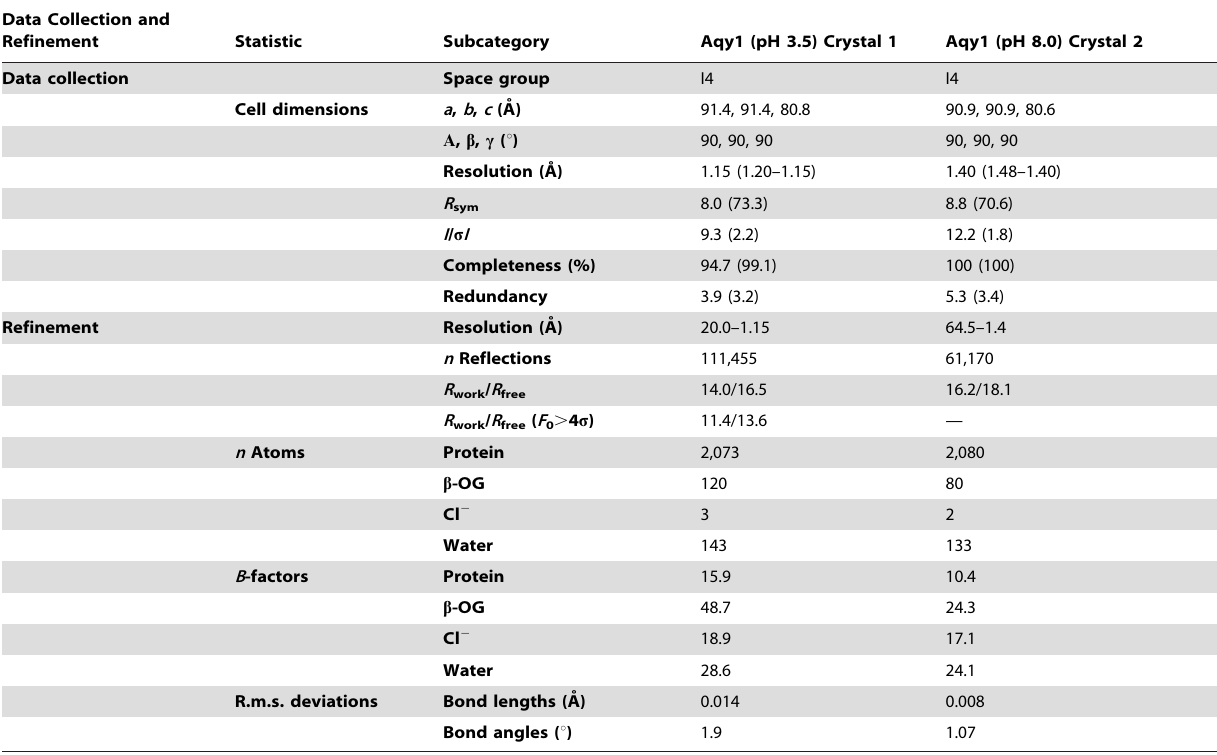
Table 1. Data collection and refinement